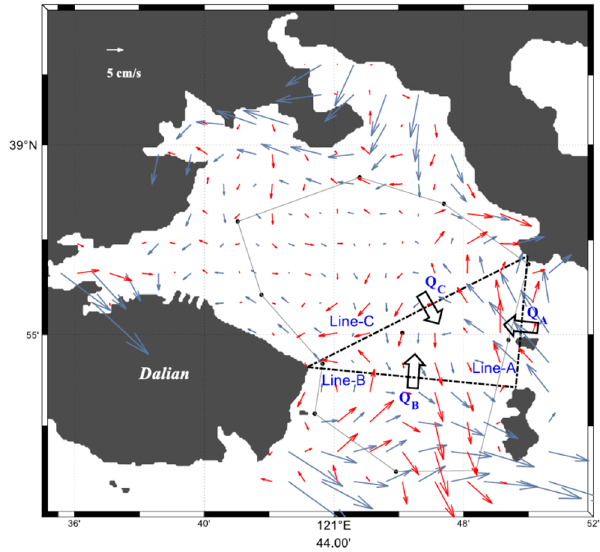
Figure 7. Distribution of the 12-h mean residual current. The red and gray arrows indicate results obtained from the CFM and NCM, respectively.